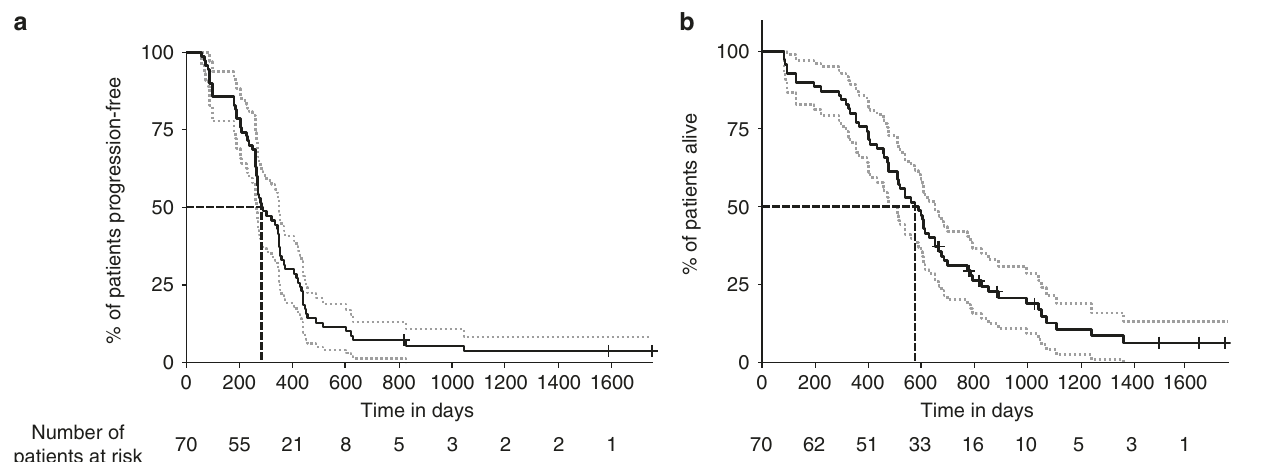
Fig. 1 Progression-free and overall survival Kaplan – Meier estimator graphs. a Shows the proportion of the 70 eligible patients who are alive and free from disease-progression; the median PFS was 283 days (9 months; 95% CI 265 – 351 days or 8.8 – 11.7 months). One year and 2 year PFS statistics were 31 and 7% respectively. Note; no patient developed PD between days 98 and 182. b Shows the proportion of the 70 eligible patients who are alive; the median OS was 578 days (19.3 months; 95% CI 477 – 651 days or 15.9 – 21.4 months). One and 2-year survival statistics were 76 and 29%, respectively. The slightly lower OS length are not statistically shorter than other published series, but likely re fl ect the eligibility requirement for at least one metastatic lesion with a diameter between 3 and 10 cm that rendered the lesion amenable to serial MRI. Solid black lines; progression-free or overall survival, dotted gray lines; 95% CI, dashed black lines; median values, black crossed; patients whose data was censored. PFS progression-free survival, OS overall survival,